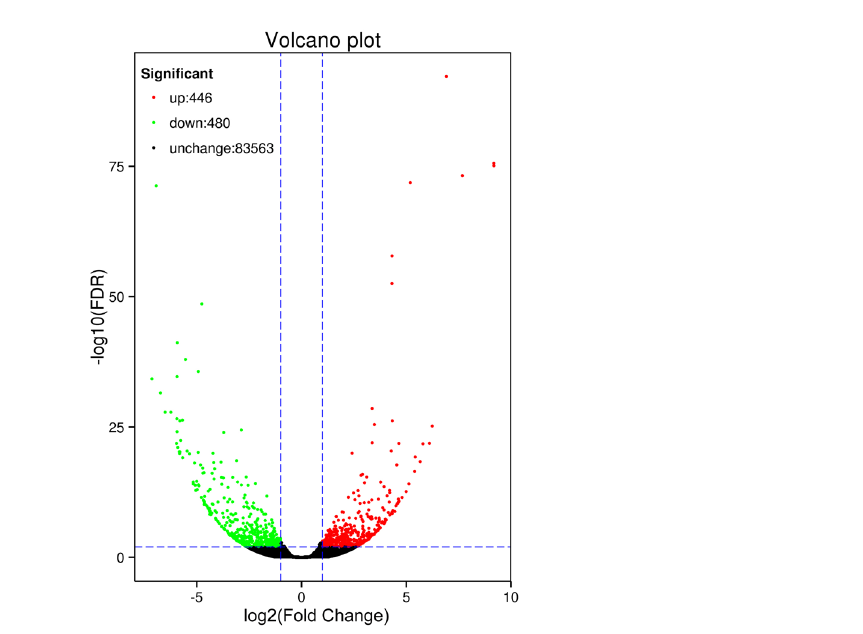
Figure 4. Expression patterns of unigenes between the B and D groups of plants. All 926 unigenes were identified as being differentially expressed (FDR < 0.01 and log2 (fold change) ≥ 2), including 448 up-regulated and 480 down-regulated genes. The red and green dots represent differentially expressed genes; the black dots indicate unchanged